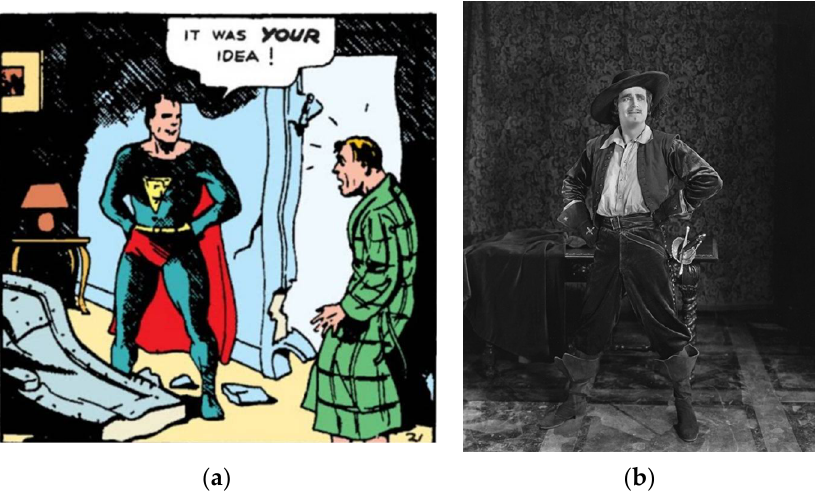
Figure 5. ( a ) Joe Shuster, Superman in a Fairbanks Stance (panel No. 21), 1938. Siegel and Shuster (June 1938), “Superman,” Action Comics #1 (Siegel and Shuster 1938a, p. 10). © DC Comics; ( b ) Douglas Fairbanks, The Iron Mask , 1929. Photo: Wikipedia Commons, Public Domain.